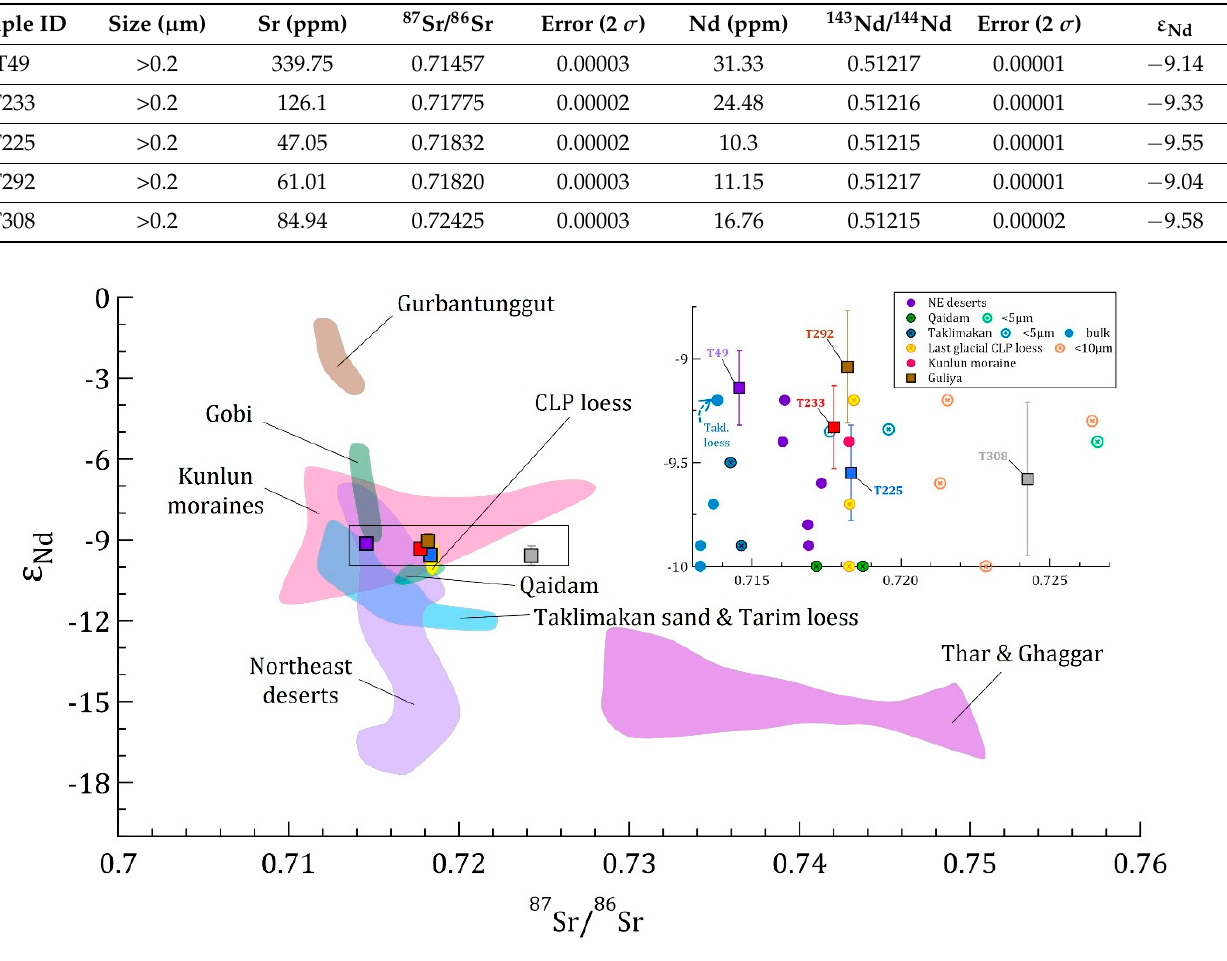
Figure 11. ε Nd vs. 87 Sr/ 86 Sr of the five Guliya dust filters (squares) compared to Sr and Nd isotopic arrays of (<75 µ m) dust sampled in Chinese deserts: Gurbantunggut, Qaidam [37], Gobi [26], Taklimakan sand and Tarim loess [36,37], Kunlun moraines [92], CLP loess [37], Northeast deserts including Mu Us, Hobq and Badain Jaran deserts [36]; and Indian deserts Thar [39] and Ghaggar river sediments [103]. The inset identifies the dust filter samples (squares) shown in the main figure and individual data points for the Chinese deserts’ arrays within the rectangle. Data points for the clay-size fraction of surface Qaidam sand (<5 μ m, [37]) and last glacial CLP loess (<10 μ m, [30]) are also shown (crossed circles) as they can be compared to the naturally size sorted T308 sample (fine grey clay).